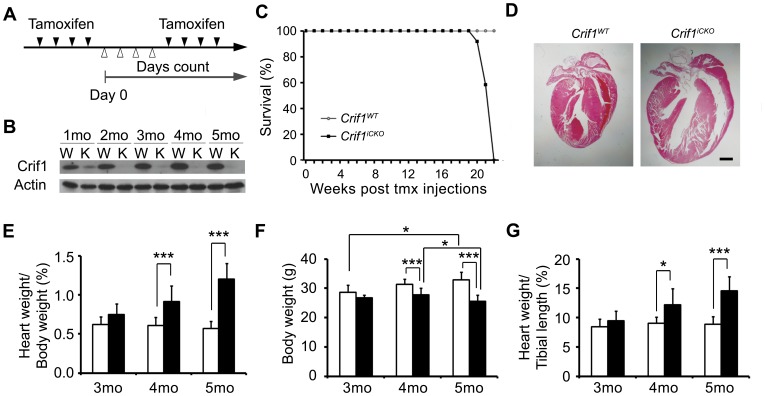
Inducible excision of Crif1 in adult cardiac myocytes causes cardiac hypertrophy.(A) Scheme of tamoxifen injections. 6 week old Crif f/f (Crif1WT) and Myh6-cre/Esr1;Criff/f (Crif1iCKO) mice were administrated with tamoxifen intraperitoneally at a dose of 20 mg/kg/day, for 8 days. Black arrows, days with injections. White arrows, days without injections. Day 0, start of days counted. (B) Western blot analysis of Crif1 expression in Crif1WT and Crif1iCKO hearts at 1∼5 months post tamoxifen injections (C) The survival graph of Crif1WT and Crif1iCKO mice. Survivality were checked every week after tamoxifen (txm) injections. n = 12 for both groups. (D) H&E staining of the heart sections from Crif1WT and Crif1iCKO mice at 5 months post tamoxifen injections. Scale bar, 1 mm. (E) heart weight per body weight ratio, (F) body weight and (G) heart weight per tibia length ratio of Crif1WT and Crif1iCKO mice at 3 ∼ 5 months. The tibia length of Crif1iCKO mice was not different from that of Crif1WT mice. n = 5 for each genotype at 3 months, n = 7 for Crif1WT at 4 months, n = 9 for Crif1iCKO at 4 months, n = 10 for Crif1WT at 5 months, n = 12 for Crif1WT at 5 months. Error bars show SD. *
P<0.05, ***
P<0.005.